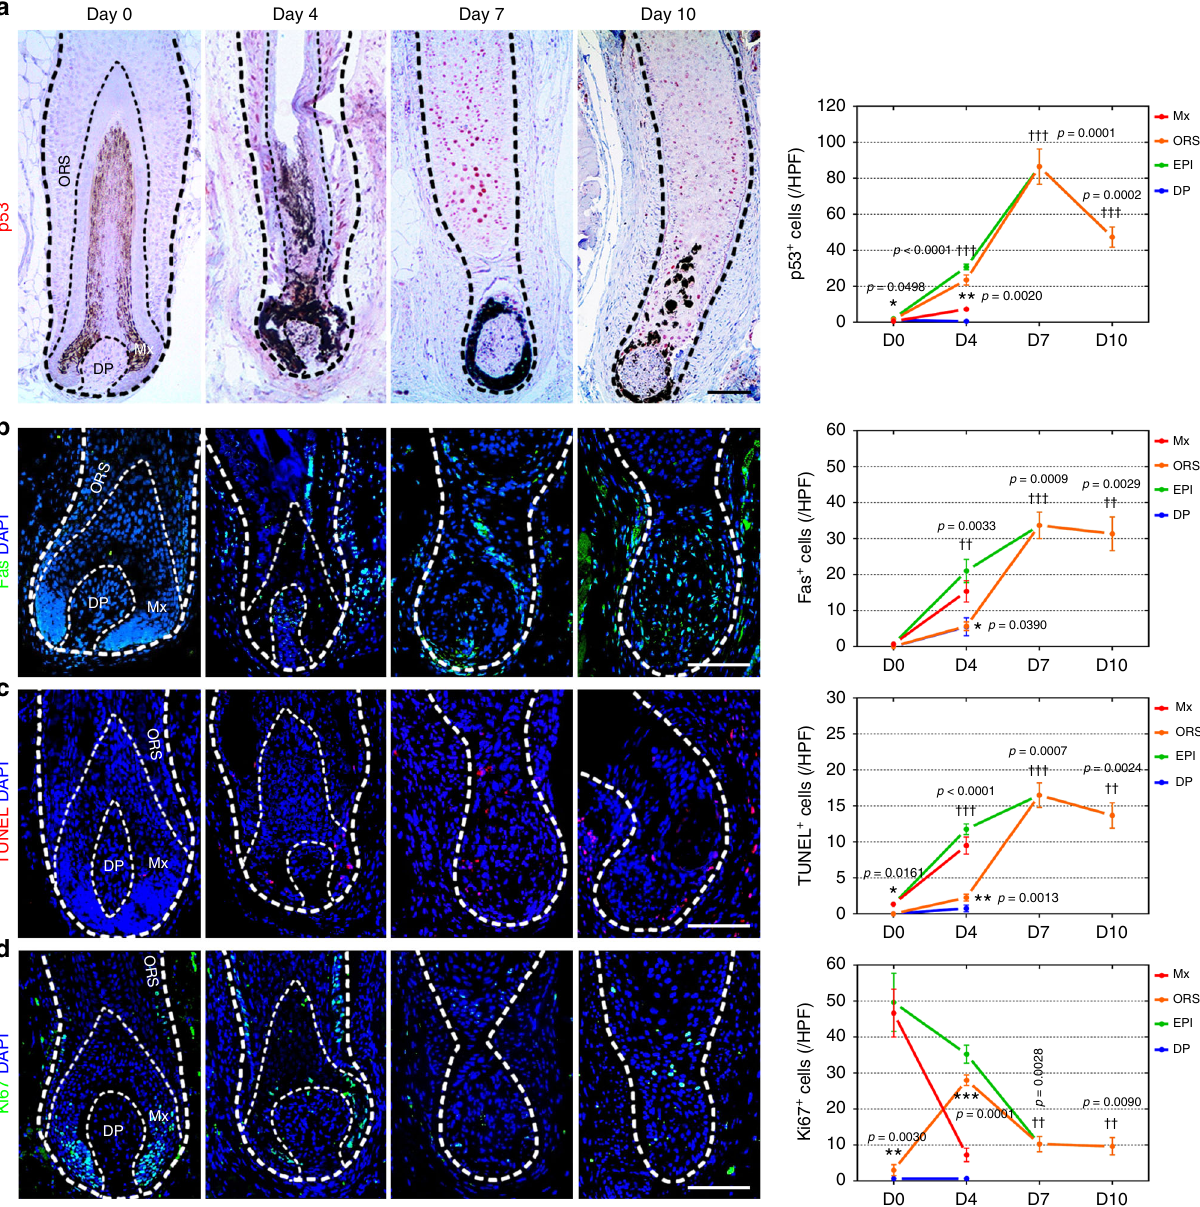
Fig. 2 Distinct spatiotemporal response after Bu/Cy treatment in the bulb. a Representative images and quanti fi cation of p53 staining to detect DNA- damaged cells in the bulb after Bu/Cy treatment ( n = 4, 4, 4, and 3 biological replicates/timepoint; immunoperoxidase). The number of p53 + DNA- damaged cells was increased in the Mx and ORS as time progressed (day 0 to 7). Representative images and quanti fi cation of b , Fas ( n = 3, 3, 3, and 3 biological replicates/timepoint) and c , TUNEL ( n = 3, 4, 4, and 3 biological replicates/timepoint) staining to detect apoptotic cell death in the bulb after Bu/Cy treatment. The number of apoptotic cells increased earlier in the Mx (day 0 to 4) than in the ORS (day 4 to 7). d Representative images and quanti fi cation of Ki67 staining to detect cellular proliferation in the bulb after Bu/Cy treatment ( n = 3, 4, 4, and 3 biological replicates/timepoint). The number of Ki67 + cells decreased in the Mx and EPI. Note that the basal ORS cells showed remarkable proliferation after Bu treatment (day 0 to 4) (immuno fl uorescence; scale bar = 100 μ m). Bu busulfan, Cy cyclophosphamide, Bu/Cy busulfan followed by cyclophosphamide, HF hair follicle, HPF high- power fi eld, Mx hair matrix, ORS outer root sheath, EPI epithelium (combined zone of Mx and ORS), DP dermal papilla. Data are mean ± SEM. Source data are provided as a Source Data fi le. * p < 0.05 (ORS vs. Mx); ** p < 0.01 (ORS vs. Mx); *** p < 0.001 (ORS vs. Mx, unpaired t test); † p < 0.05 (EPI vs. D0); †† p < 0.01 (EPI vs. D0); ††† p < 0.001 (EPI vs. D0, unpaired t